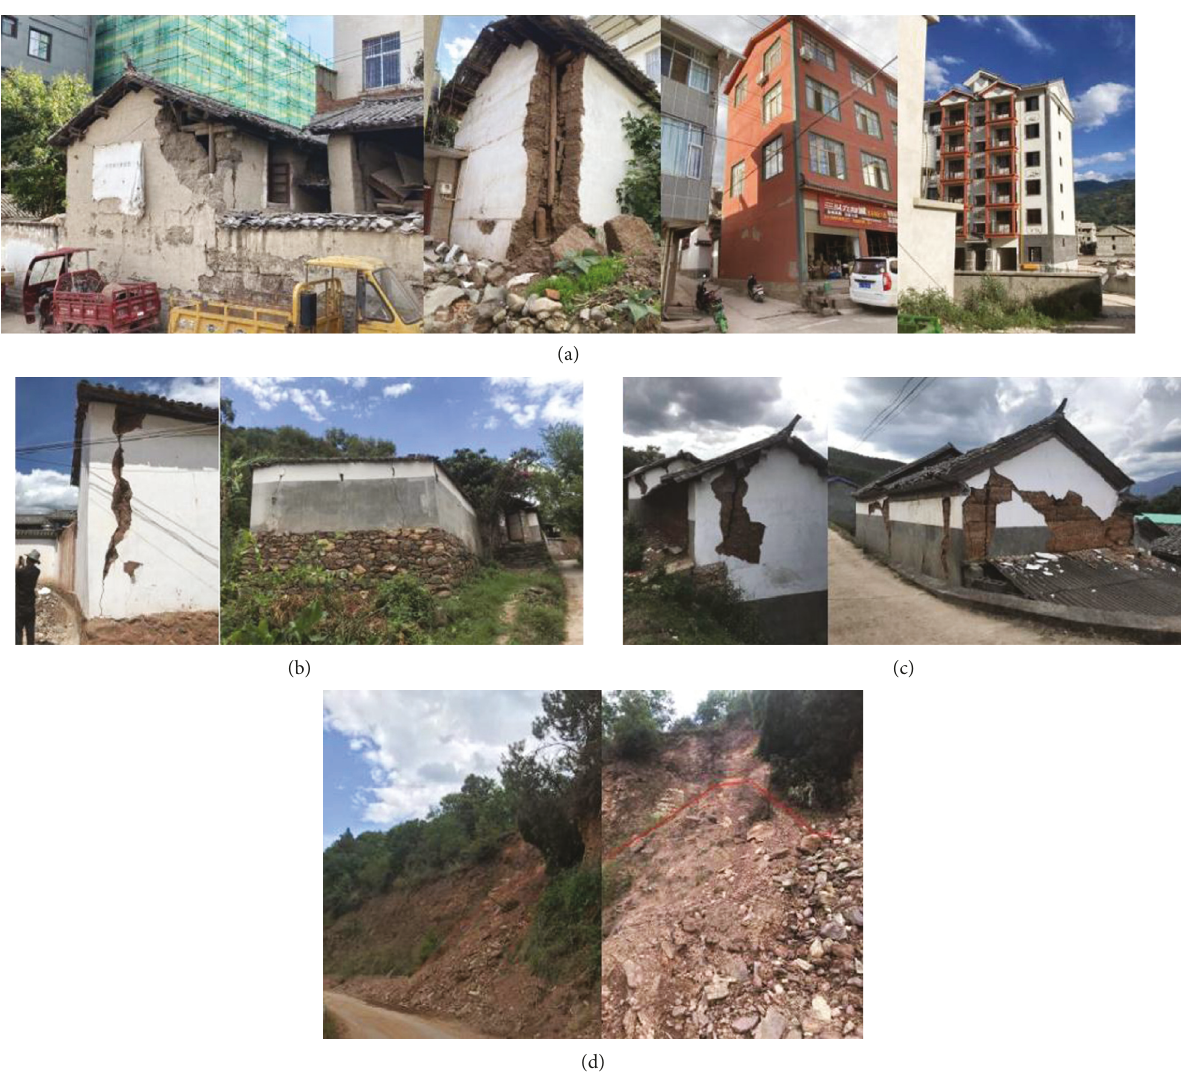
Figure 5: Typical seismic damage phenomenon in Yangbi Ms 6.4 earthquake. (a) Damaged buildings in Xiajie Village, Yangbi County. (b) Damaged buildings in Huaian Village. (c) Damaged buildings in Shahe Village. (d) Small landslides in Shahe Village.